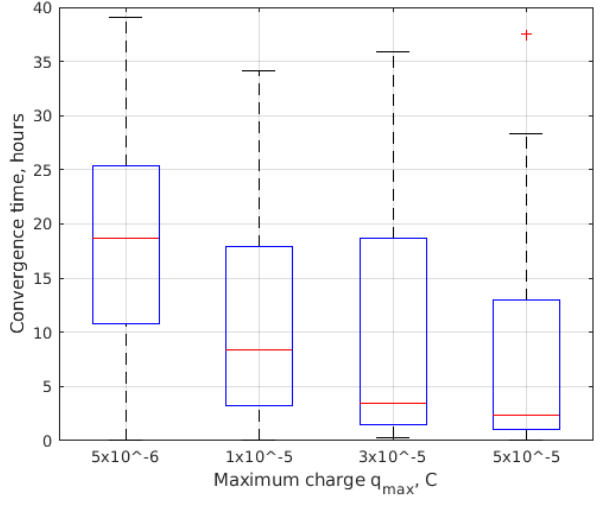
q . Figure 14. Convergence time depending on maximal charge value q max max